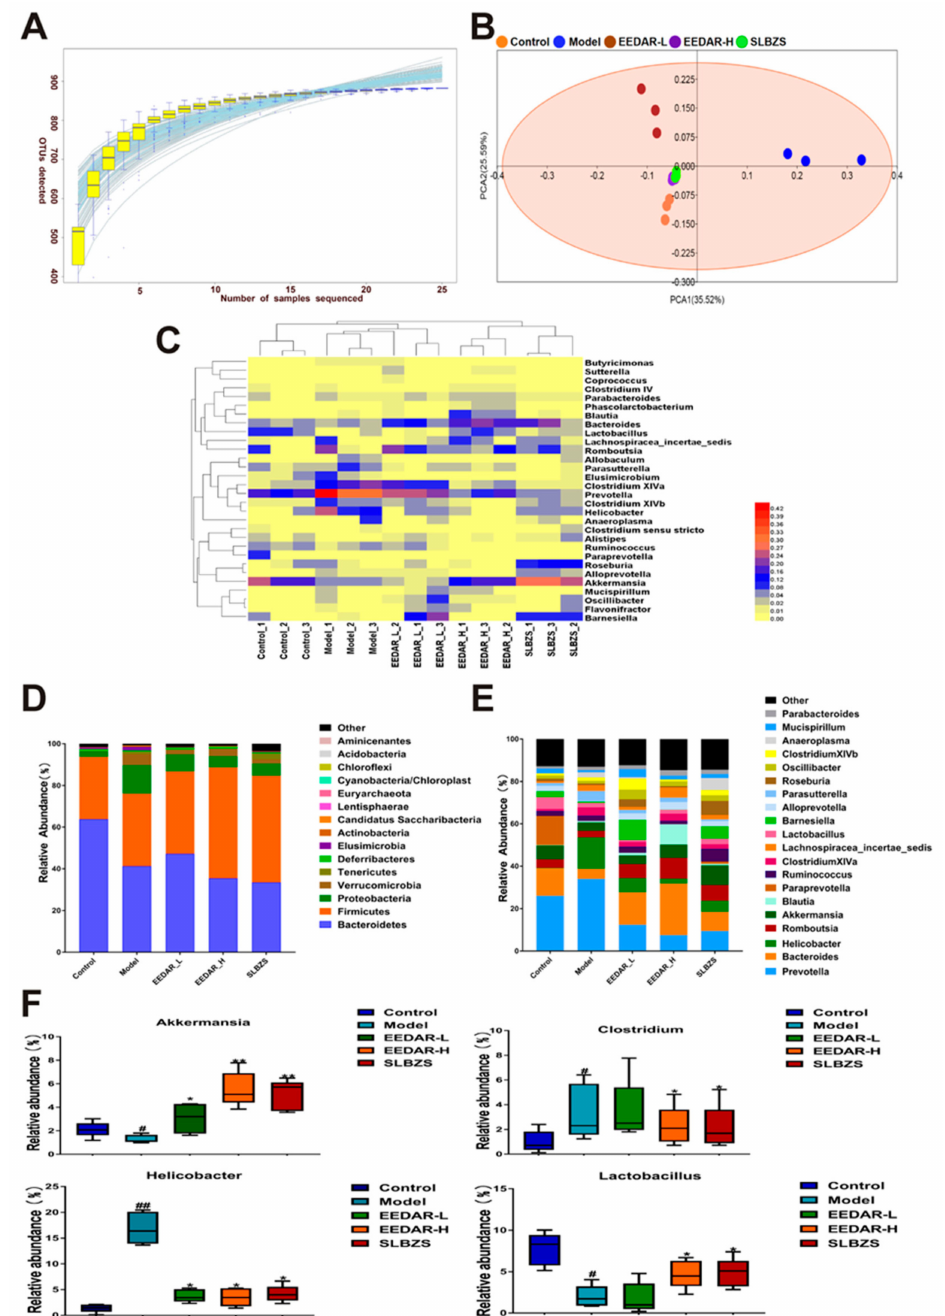
Figure 7. E ff ects of EEDAR on the overall structure of the gut microbiota in spleen-deficiency diarrhea rats ( n = 3). ( A ) Sample number and species richness were estimated from a species accumulation boxplot. ( B ) PCA demonstrated distinct structural changes in the overall bacterial community for each group. ( C ) Heatmap demonstrating the relative abundance of intestinal bacteria at the genus level. ( D ) Microbial community bar plot at the phylum level. ( E ) Microbial community bar plot at the genus level. ( F ) Relative abundance of di ff erent microbial flora. Values represent means ± SEM. # p < 0.05, ## p < 0.01 vs. Control; * p < 0.05, ** p < 0.01 vs.